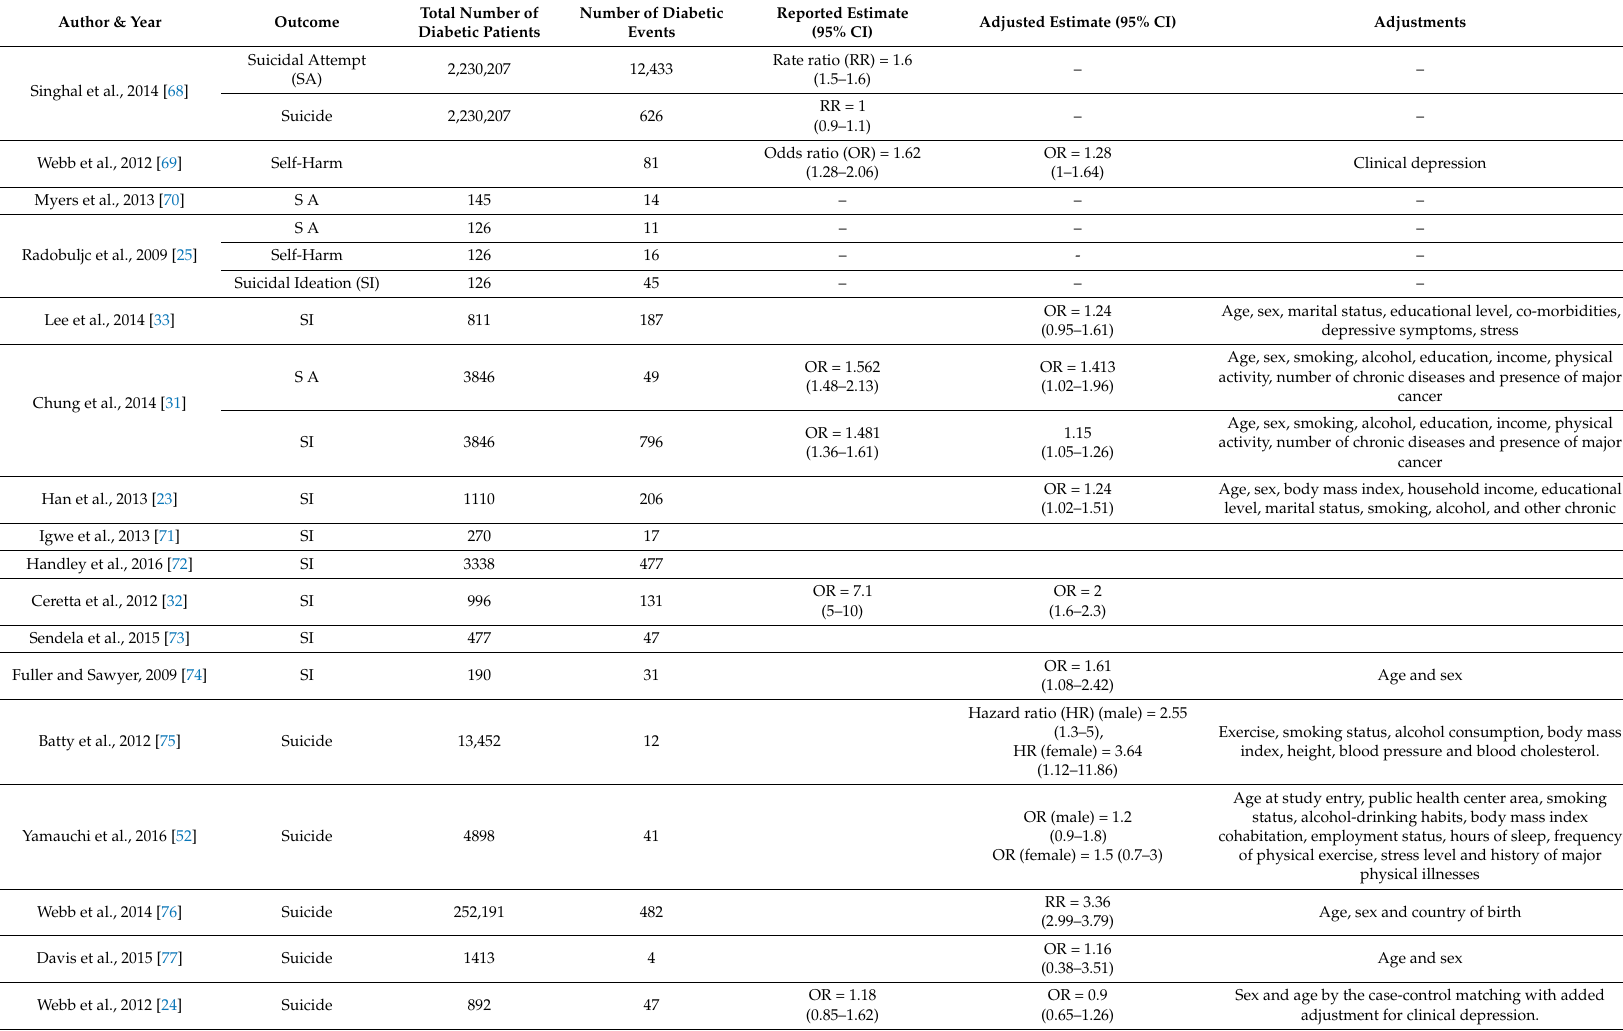
Table 4. Data from selected suicidality studies for systematic review and meta-analysis (suicidality